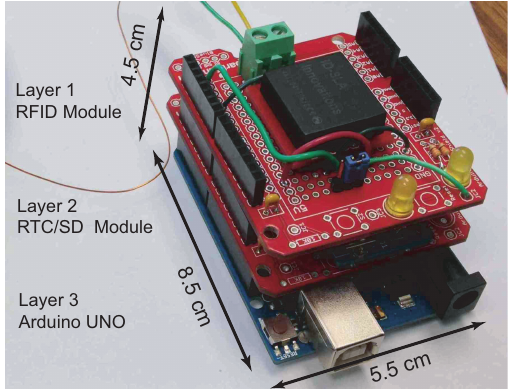
Figure 5. Electrical subsystem in the smart feeder system. The three layer board hosts RFID reader, real-time clock (RTC)/SD module, and the Arduino microcontroller